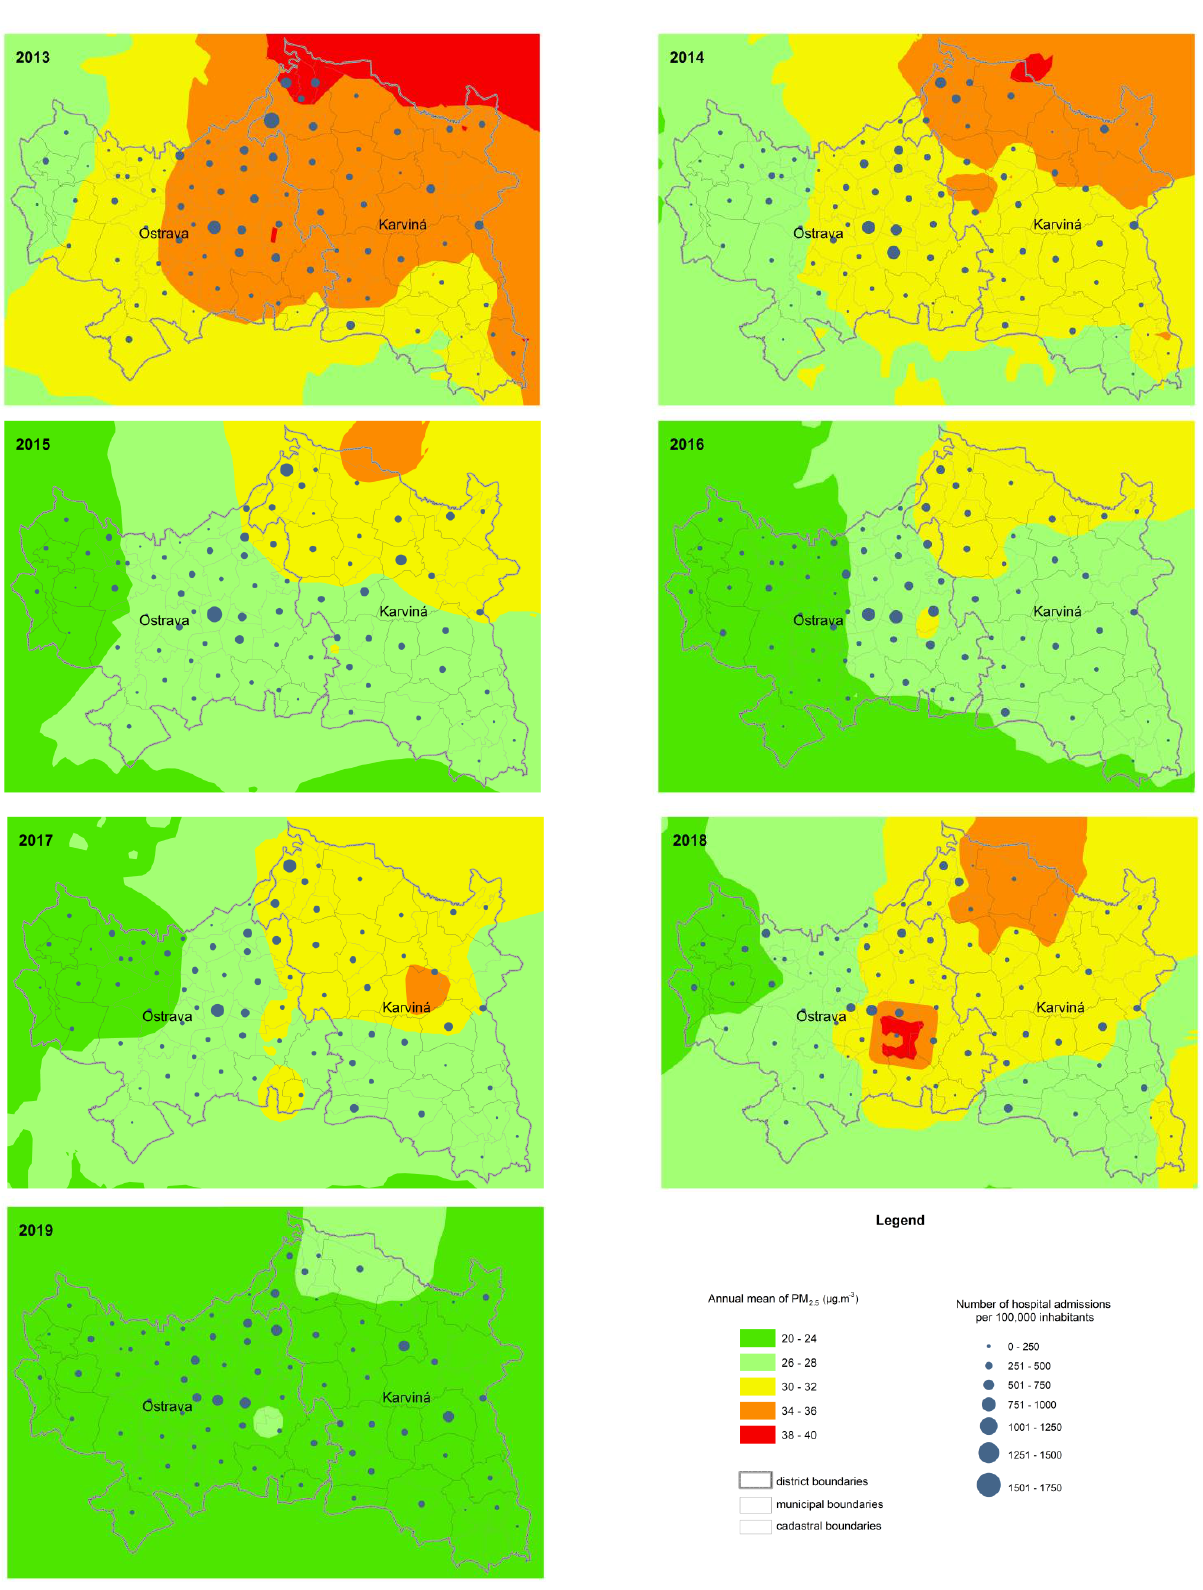
Figure 2. Hospital admissions for circulatory system diseases (I00-I99) per 100,000 population dur- ing the individual years of the study period.